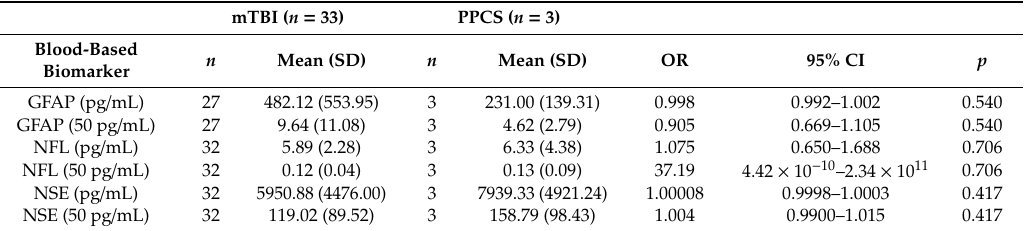
Table 3. Exact logistic regression odds ratios for PPCS for blood-based biomarkers. mTBI ( n = 33) PPCS ( n = 3) Blood-Based n Mean Biomarker